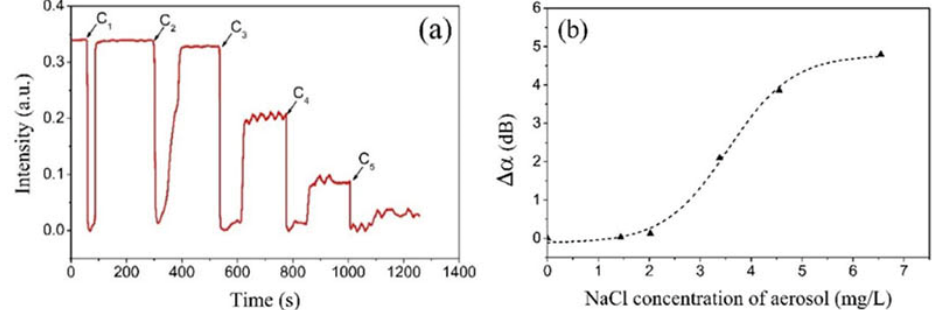
Figure 11. Experimental results: ( a ) temporal responses of the COWG to step-by-step aerosol salt deposition with 5 different salt concentrations of saline solution (deposition time of 15 s for each concentration); ( b ) attenuation variations Δα as a function of the salt concentration of saline solution.